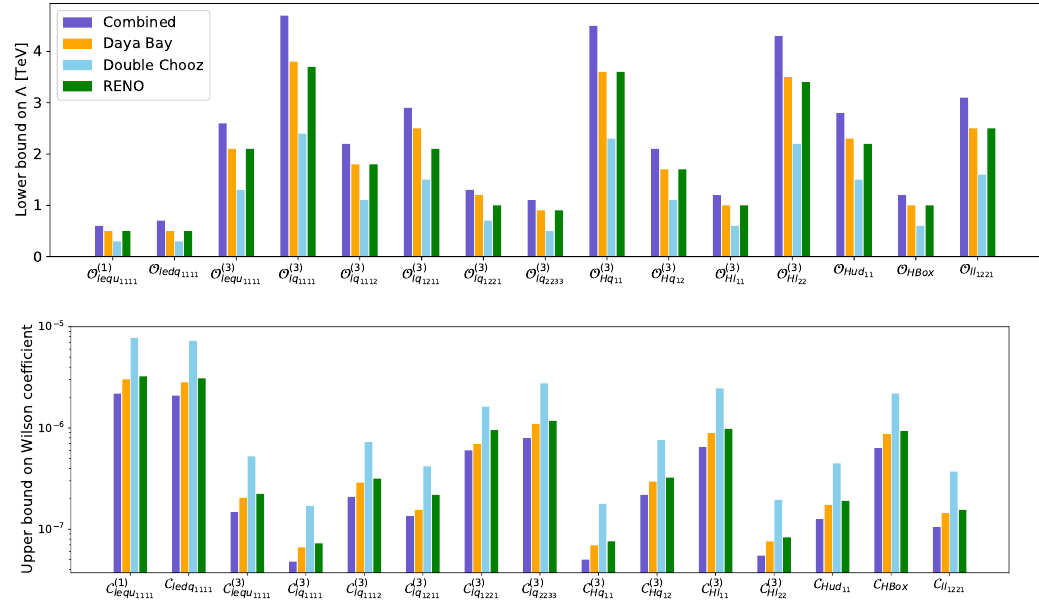
Figure 9 . Constraints on part of dimension-6 operators in tables 7 and 8 in reactor neutrino experiments Daya Bay, Double Chooz and RENO. The new physics scale Λ associated with a specific operator is constrained from below and the corresponding Wilson coefficient from above when Λ = 1 TeV. The results are obtained at 95%